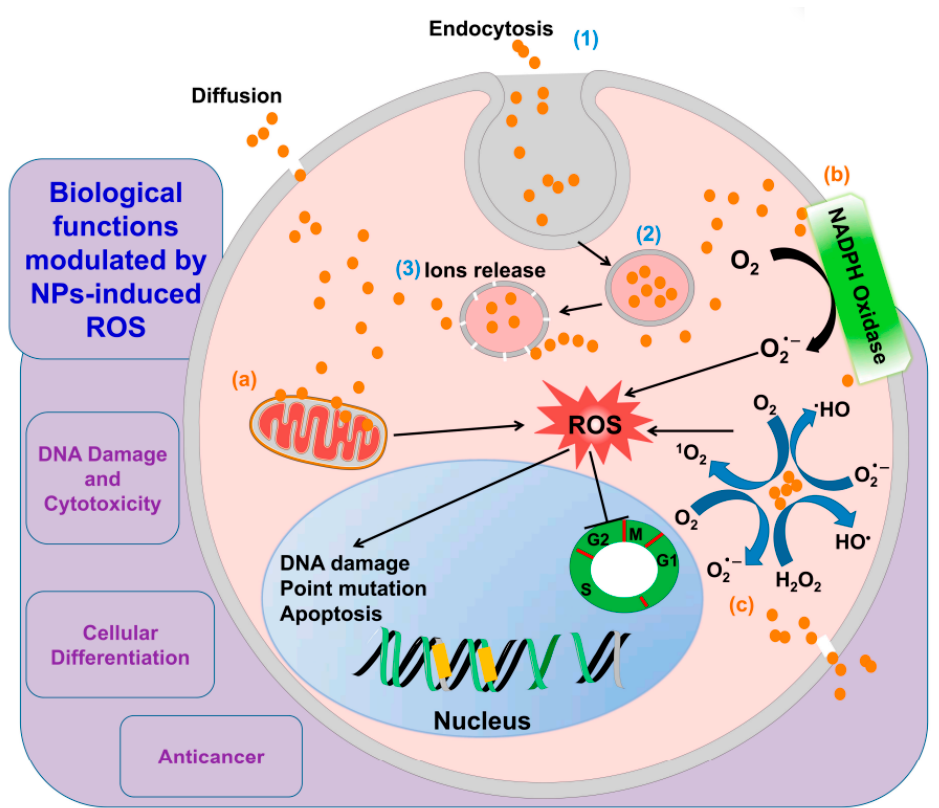
Figure 11. ROS generation mechanisms of NPs, after entering a cell via a sequence of (1) endocytosis; (2) endocytotic vesicle formation; and (3) ion release from the vesicles into the intracellular medium. ROS is generated by the NPs through ( a ) interaction with the mitochondria; ( b ) interaction with NADPH oxidase; and ( c ) factors related to the physicochemical properties, such as size, shape, photoreactive properties, and surface chemistry. Reprinted from [316] under the terms of the Creative Common CC BY license.